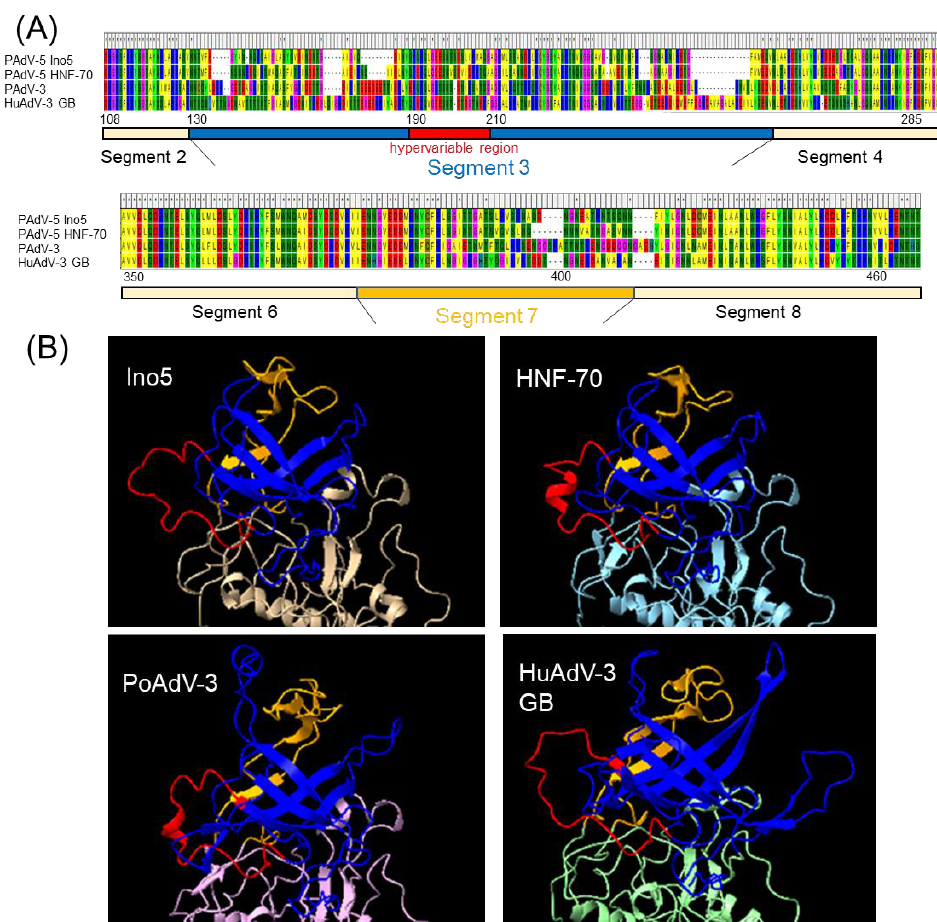
Figure 4. Alignment of aa partial hexon protein sequences of PAdV-5 Ino5, PAdV-5 HNF-70 (AF289262), porcine adenovirus 3 (AC_000189), and Human adenovirus 3 GB strain (AY599834) ( A ) Structure prediction and comparison of the hexon tower region of PAdV-5 Ino5, PAdV-5 HNF-70, porcine adenovirus 3, and Human adenovirus 3 GB strain. The three-dimensional protein structures were predicted by Alphafold2 (https://colab.research.google.com/github/sokrypton/ColabFold/blob/main/AlphaFold2.ipynb accessed on 1 September 2022) and visualized in ChimeraX. The predicted 3D structure of the tower region of the hexon protein segment 3, hypervariable region in the segment 3, and segment 7 are colored by blue, red, and orange ( B ).